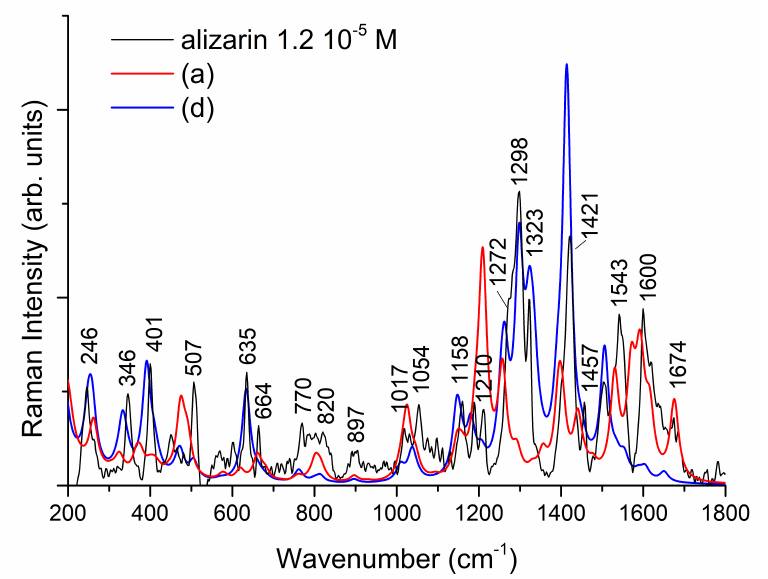
Figure 7. Comparison of the measured SERS spectra of alizarin with those calculated for the a and d models shown in Figure 5. The calculated intensities were uniformly scaled to match the